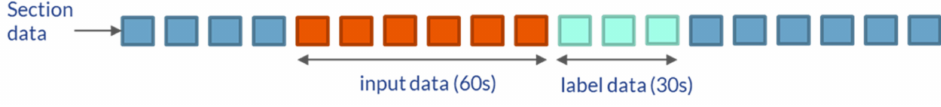
Figure 5. Configuration of input and label data through window size